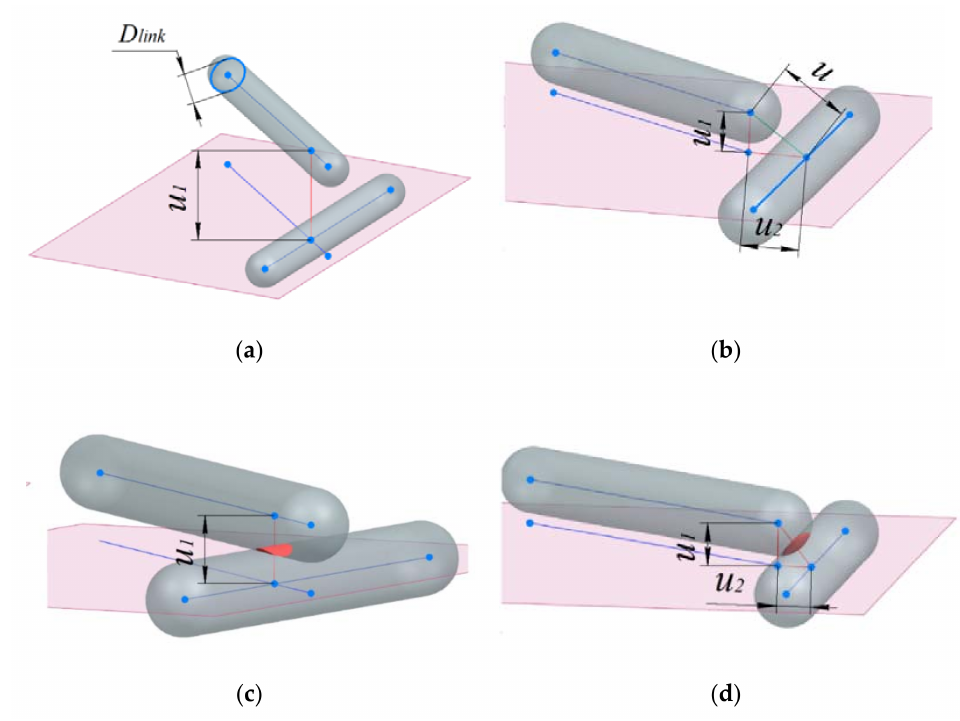
Figure 5. Checking the intersection of links for case 2 —( a ) no intersection for u 2 = 0, ( b ) no intersection for u 2 > 0, ( c ) intersection for u 2 = 0, ( d ) intersection for u 2 >